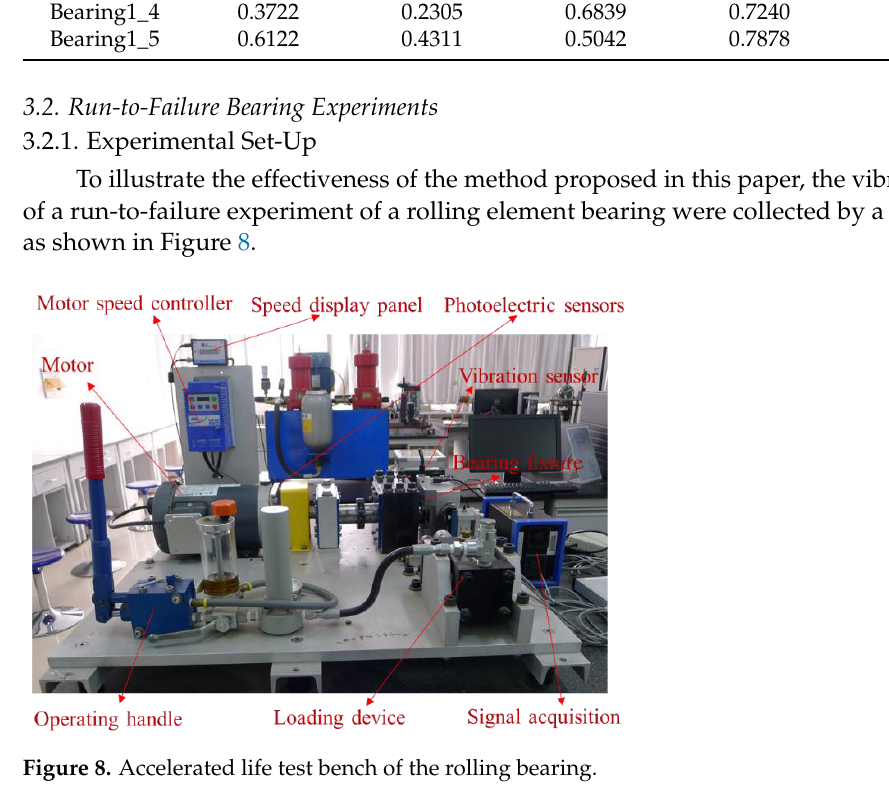
Table 4 . Main geometric parameters of rolling bearing ERK16. Type ( b ) Figure 9. ( a ) The spectrum of the original non-stationary signal; ( b ) the stationary signal after angu- lar domain transformation.